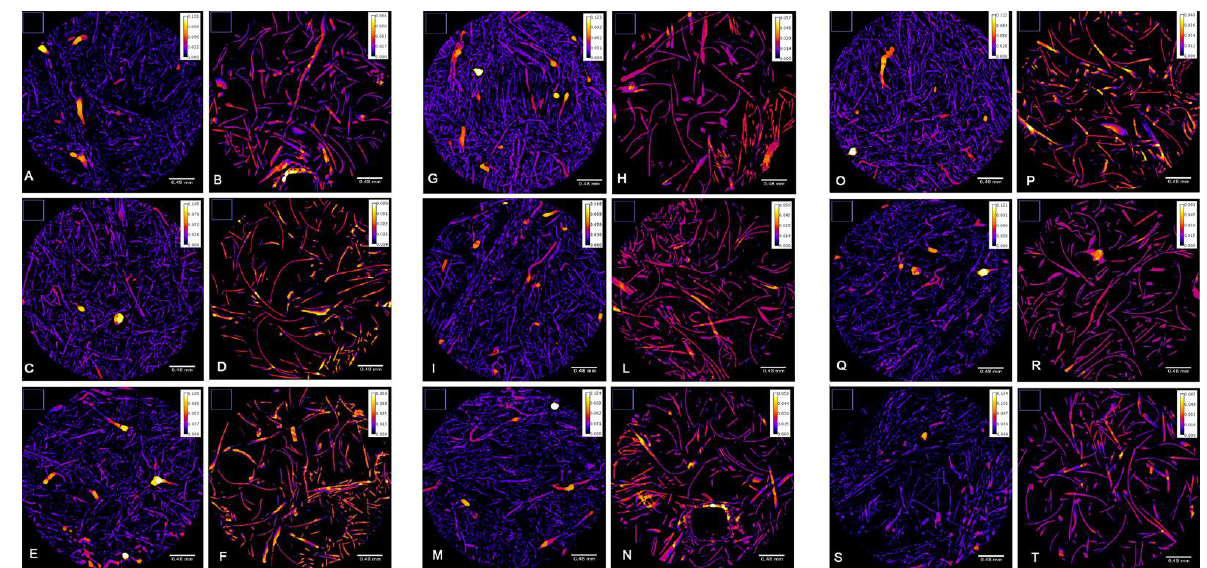
Figure 4. Colorimetric map of the fiber thickness in filter samples. The first two columns represent ( A , B ) the thickness of the finer and coarser layers of control Sample 1, ( C , D ) control Sample 2, and ( E , F ) control Sample 3. The second panel represent the thickness of the finer and coarser layers of ( G , H ) 60 °C-treated Sample 1, ( I , L ) 60 °C-treated Sample 2, and ( M , N ) 60 °C-treated Sample 3. The third panel represents the thickness of the finer and coarser layers of ( O , P ) UV-irradiated Sample 1, ( Q , R ) UV-irradiated Sample 2, and ( S , T ) UV-irradiated Sample 3.